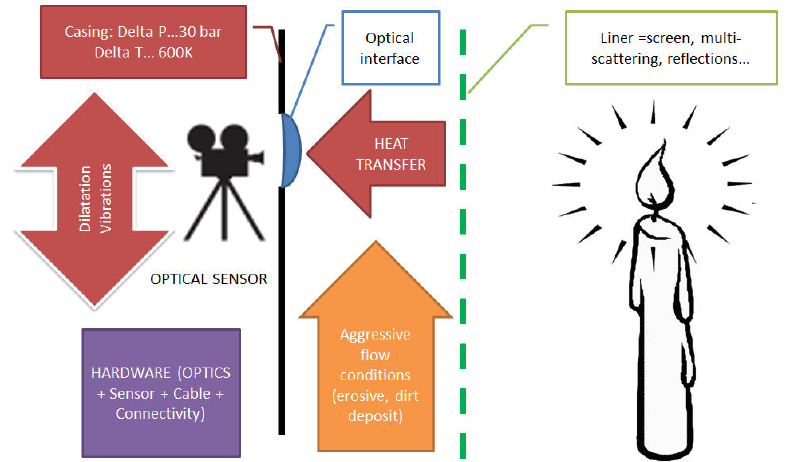
Figure 1. The technical challenge of including an optical measurement technique in the combustor environment of a gas